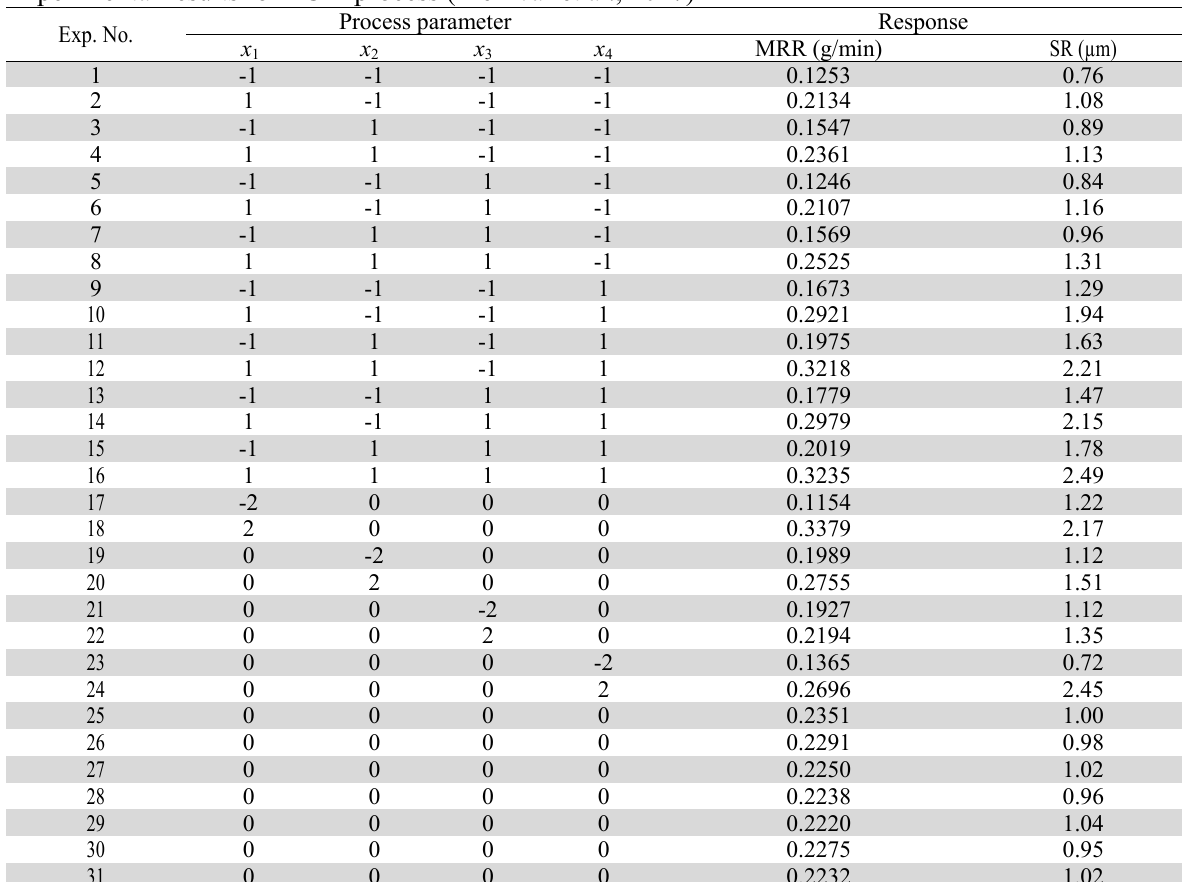
Experimental results for ECM process (Mehrvar et al., 2017) Exp.